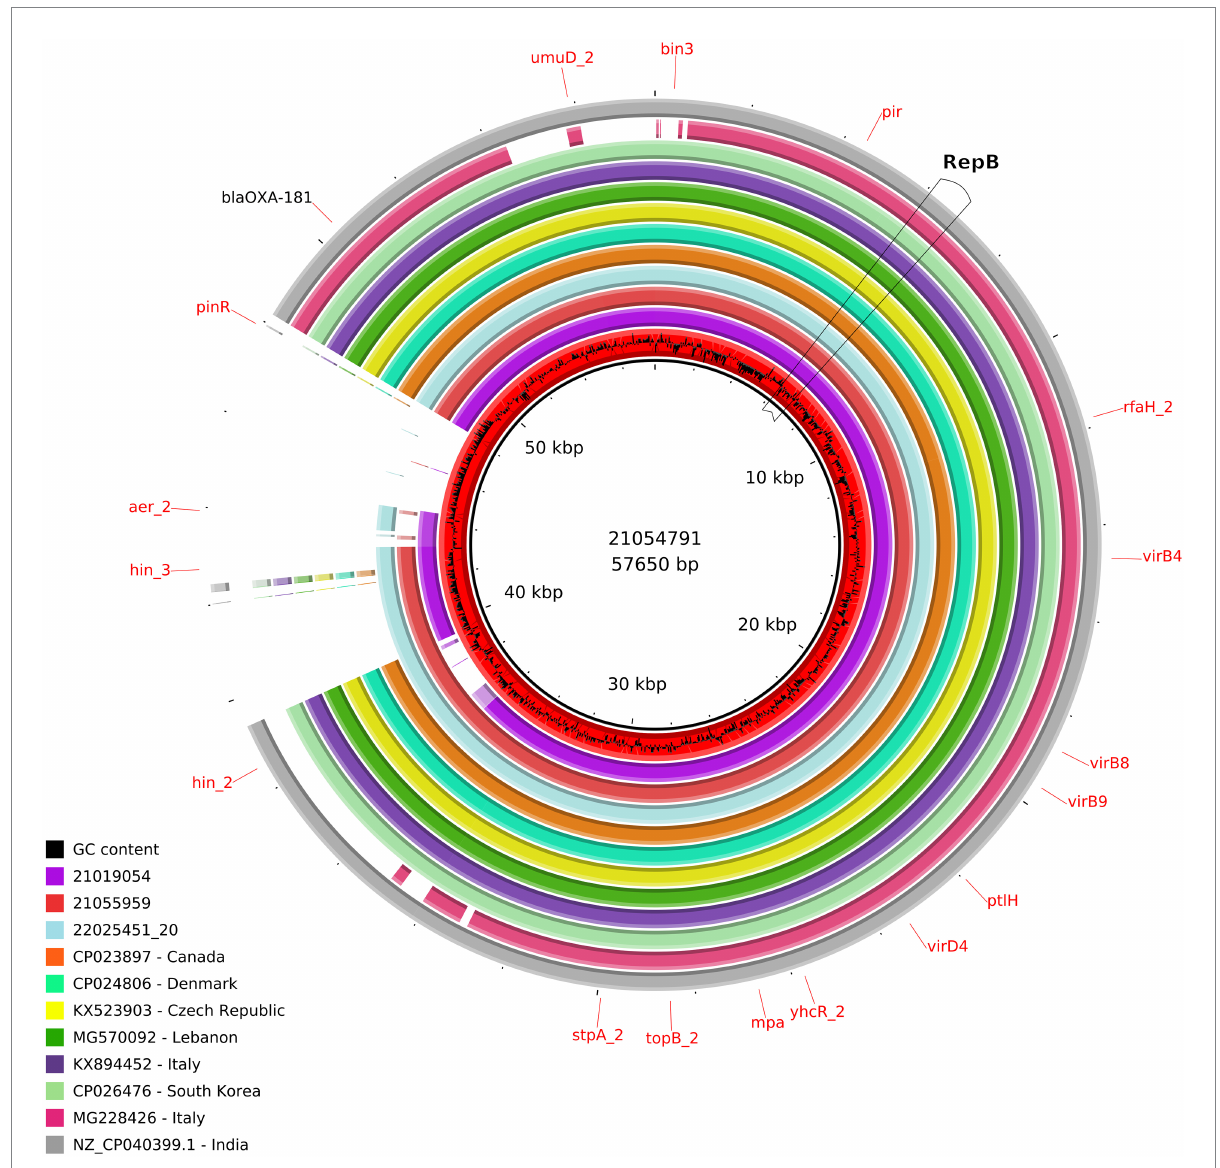
FIGURE 3 Comparison of the IncX3 plasmids obtained in this study and publicly available IncX3 plasmids containing bla OXA-181 . From the inner circle, the plasmids represented were the following: red: ID21054791 used as reference (accession number ERS12413439), including the CG content graph (sequenced in this study, Escherichia coli , caecal content, pig 2021), violet: ID21019054 (sequenced in this study, E. coli , pig caecal content 2021), light red: ID21055959 (sequenced in this study, E. coli , pig caecal content, 2021), turquoise: ID22025451_20 (sequenced at the Italian NRL-AR; Citrobacter freundii , pig feces, 2022), orange: FDAARGOS_433 (CP023897, Canada, E. coli , human, 2017), hospital green: pAMA1167_OXA_181 (CP024806, Denmark, E. coli , human, 2017), yellow: pOXA_181_29144 (KX523903, Czech Republic, Klebsiella pneumoniae , human, 2016), green: pSTIB_IncX3_OXA_181 (MG570092, Lebanon, E. coli , human, 2016), purple: pOXA181 IHIT35346 (KX894452, isolated in Italy, E. coli , pig, 2016), light green: pKBN10P04869C (CP026476, South Korea, E. coli , human, 2017), pink: pKP_BO_OXA181 (MG228426, Italy, E. coli , human, 2017), and gray: (NZ_CP040399.1, India, E. coli , human,